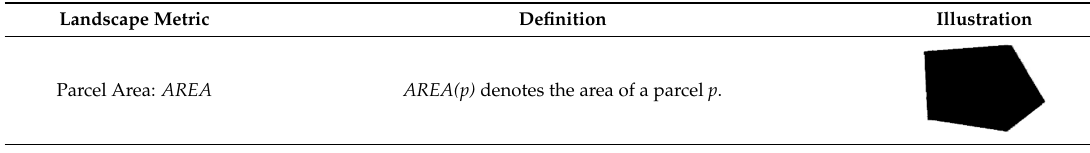
Table 3. Selected landscape metrics used to evaluate urban layout components [40].